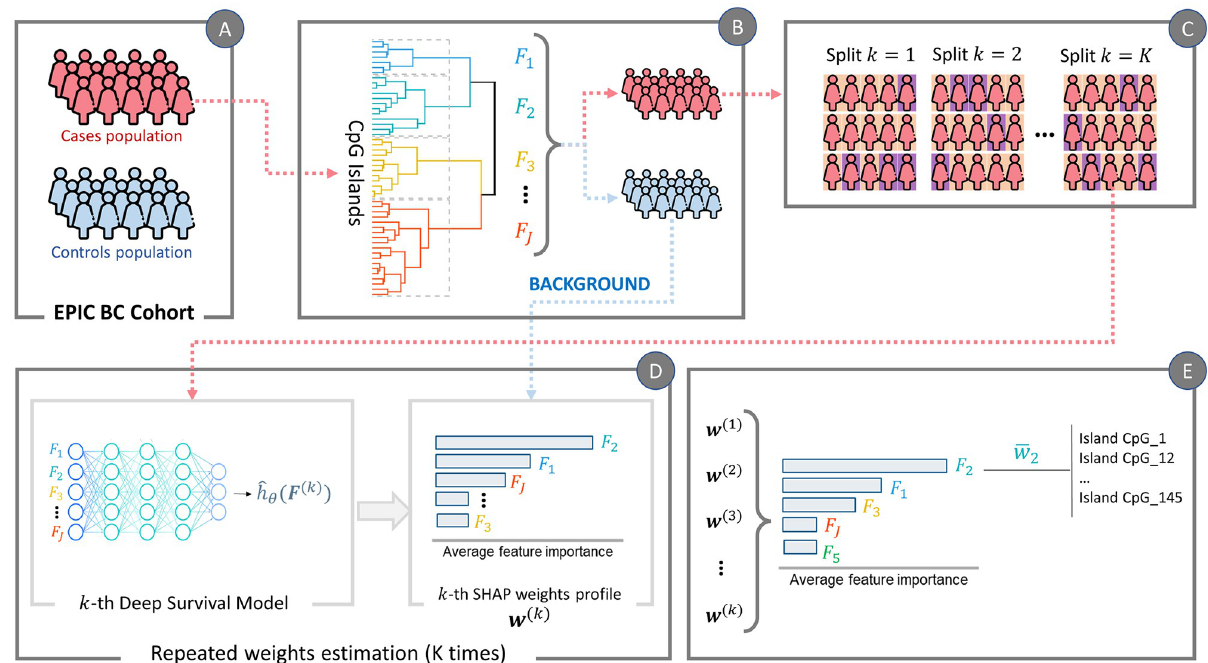
Fig 1. Algorithm pipeline of the methodology applied in this study. (A) We started from the EPIC BC cohort, equally split between cases (i.e., patients enrolled healthy but diagnosed with BC within the study time frame) and matched controls (i.e. patients matching cases at baseline, that were not diagnosed with BC within the study time frame). (B) The first step is feature aggregation via hierarchical clustering, exploiting CpG Islands continuous β values of the population of cases to infer the J clusters of features. The same clustering structure is then applied to both cases and controls, grouping their CpG Islands accordingly. (C) The cases population is exploited to generate K independent and randomly split training and test sets, each of them with 80% patients in training set and 20% patients in the test set. (D) Each of the K splits goes through step D independently. In particular, the k-th training set is used to train a Deep Survival Model, that then is used to estimate SHAP weights profiles ( w k ) on the k-th test set using the controls’ population as background data. (E) After generating independently K sets of weights profiles, they are aggregated to obtain the final estimation of the effects profile for BC